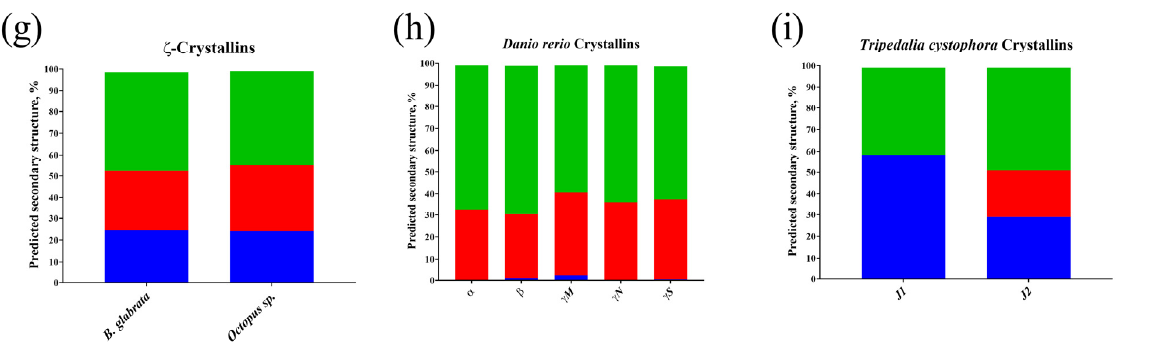
Figure 4. Mean values of the predicted secondary structures in percentages for the mollusc crystallins and lens crystallins of Danio rerio and Tripedalia cystophora